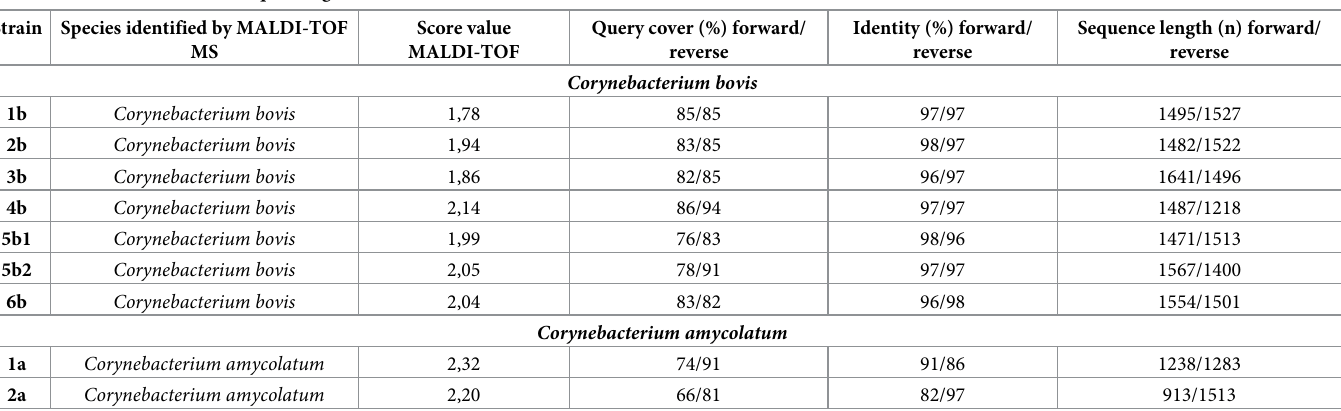
Table 5. Results of 16S rRNA sequencing. Strain Species identified by MALDI-TOF